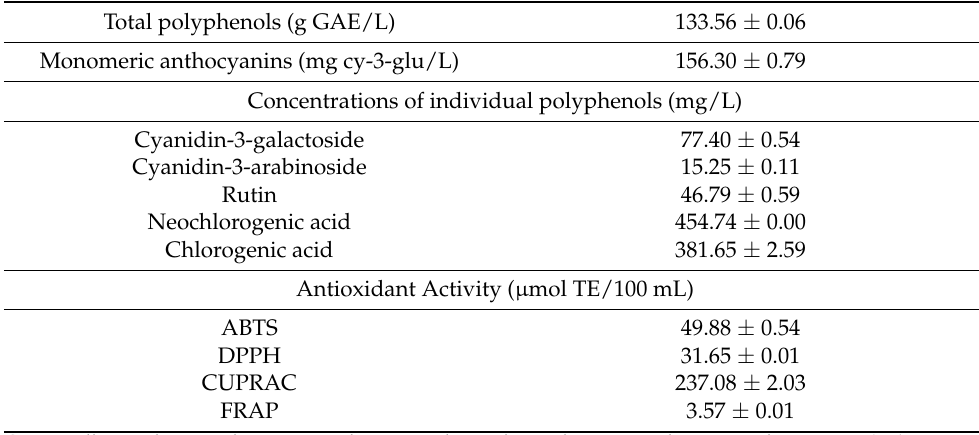
Table 3. Evaluation of chokeberry juice polyphenols and antioxidant